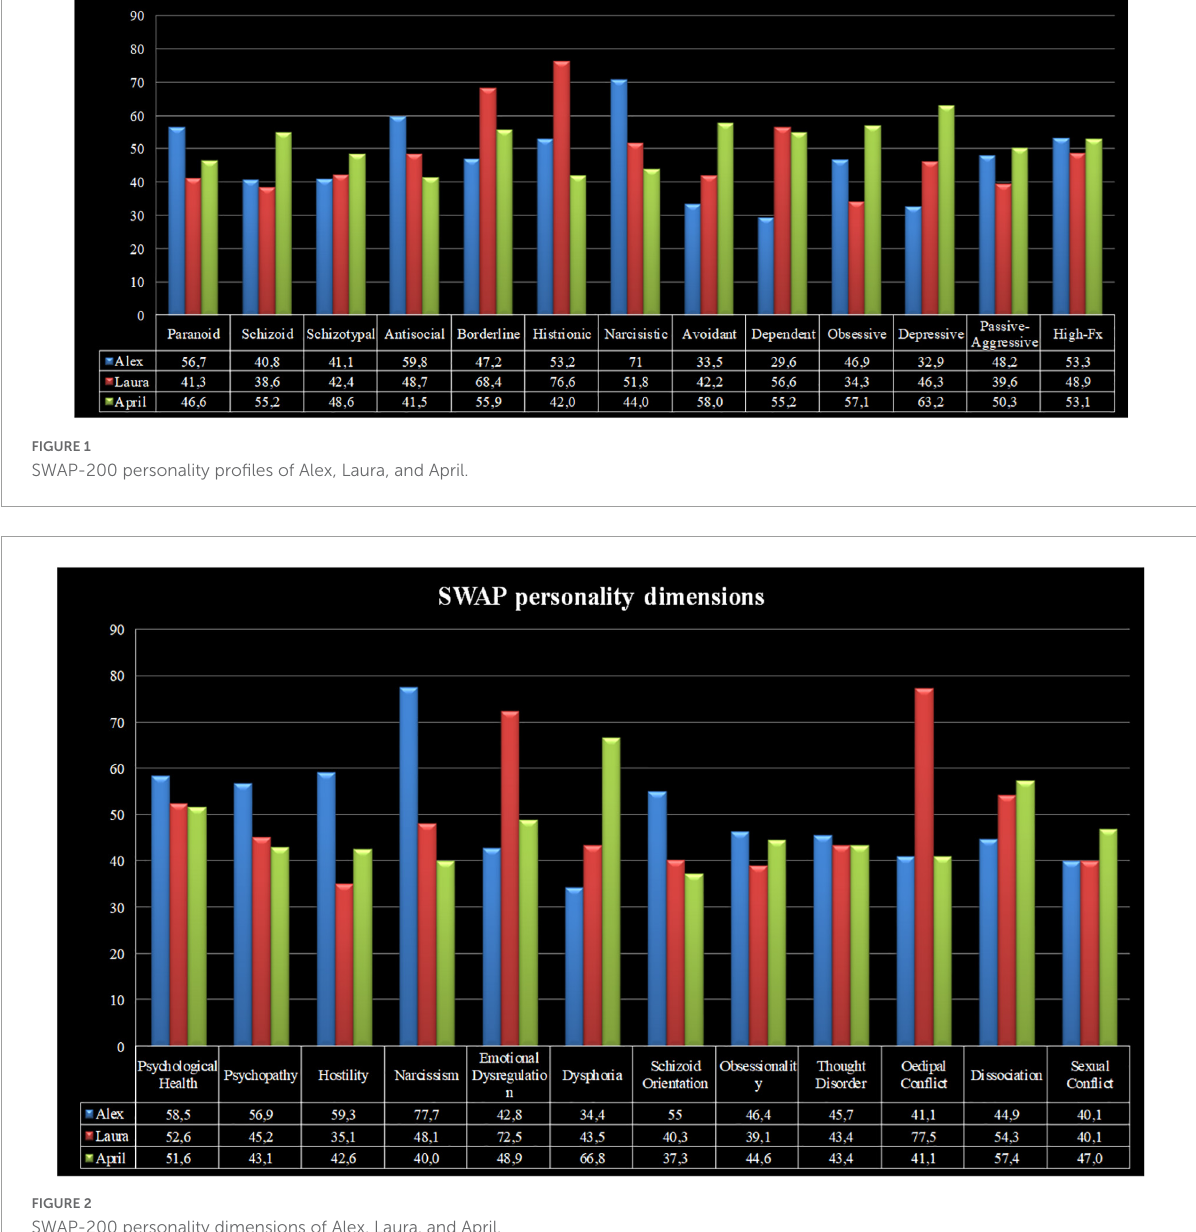
FIGURE2 SWAP-200 personality dimensions of Alex, Laura, and